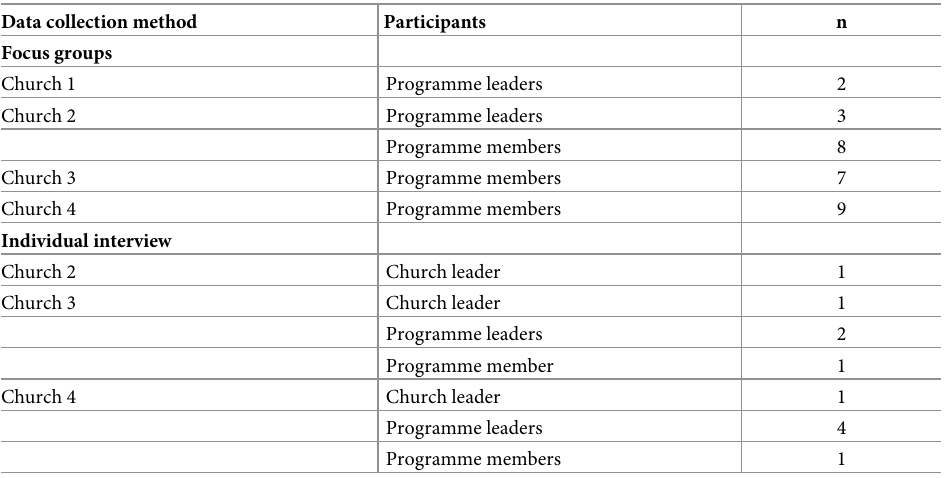
Table 4. Numbers of focus group and interview